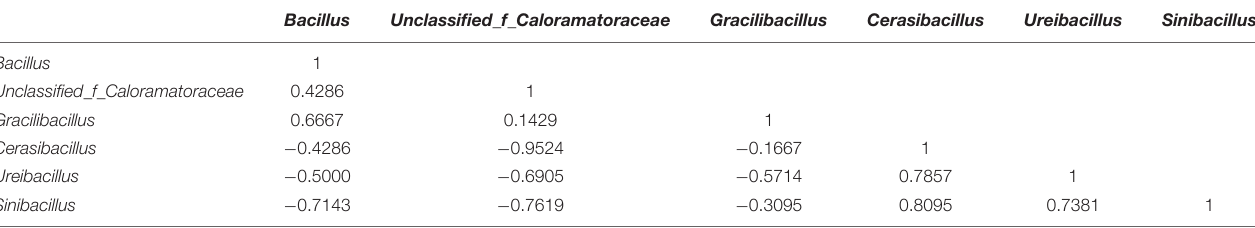
TABLE 1 | Spearman’s correlation coefficients among the relative abundance of the dominant microbes.